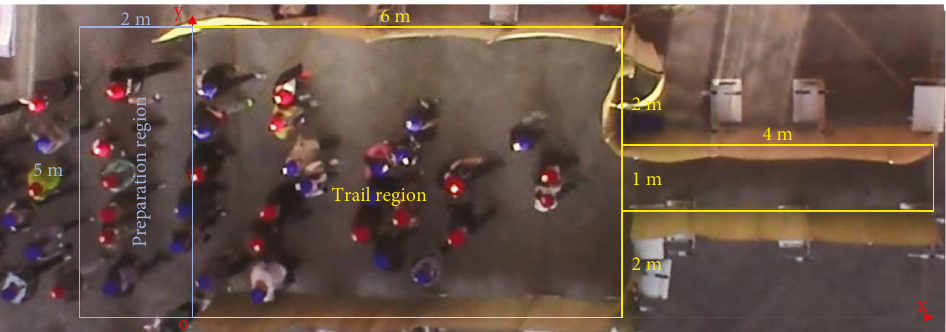
Figure 1: Settings of experimental scene.